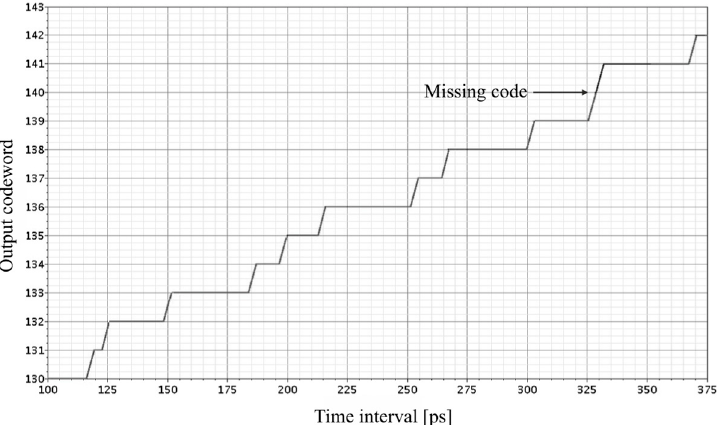
Figure 27. Transfer characteristics of 8-bit SA-TDC with T 0 = 25 ps and T m = 250 ps.